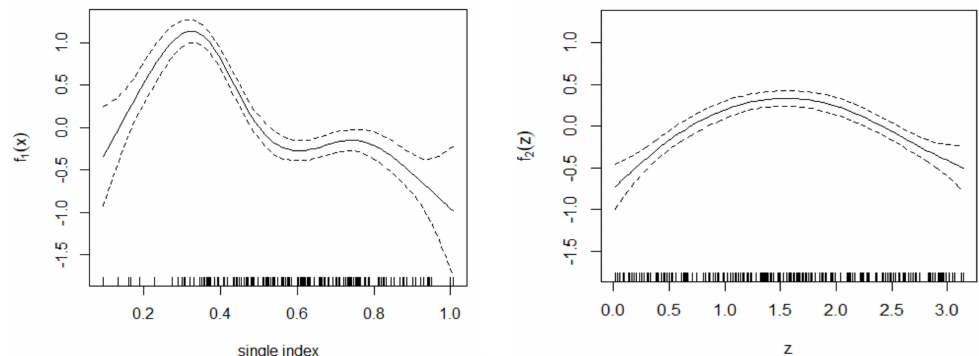
Figure 1. The p-spline smooth single index function, f 1 ( w ) and its 95% confidence interval ( left ), and the p-spline smooth function of the covariate variable, f 2 ( z ) ( right ) for one of the simulated data sets with a change point at 0.5, θ =